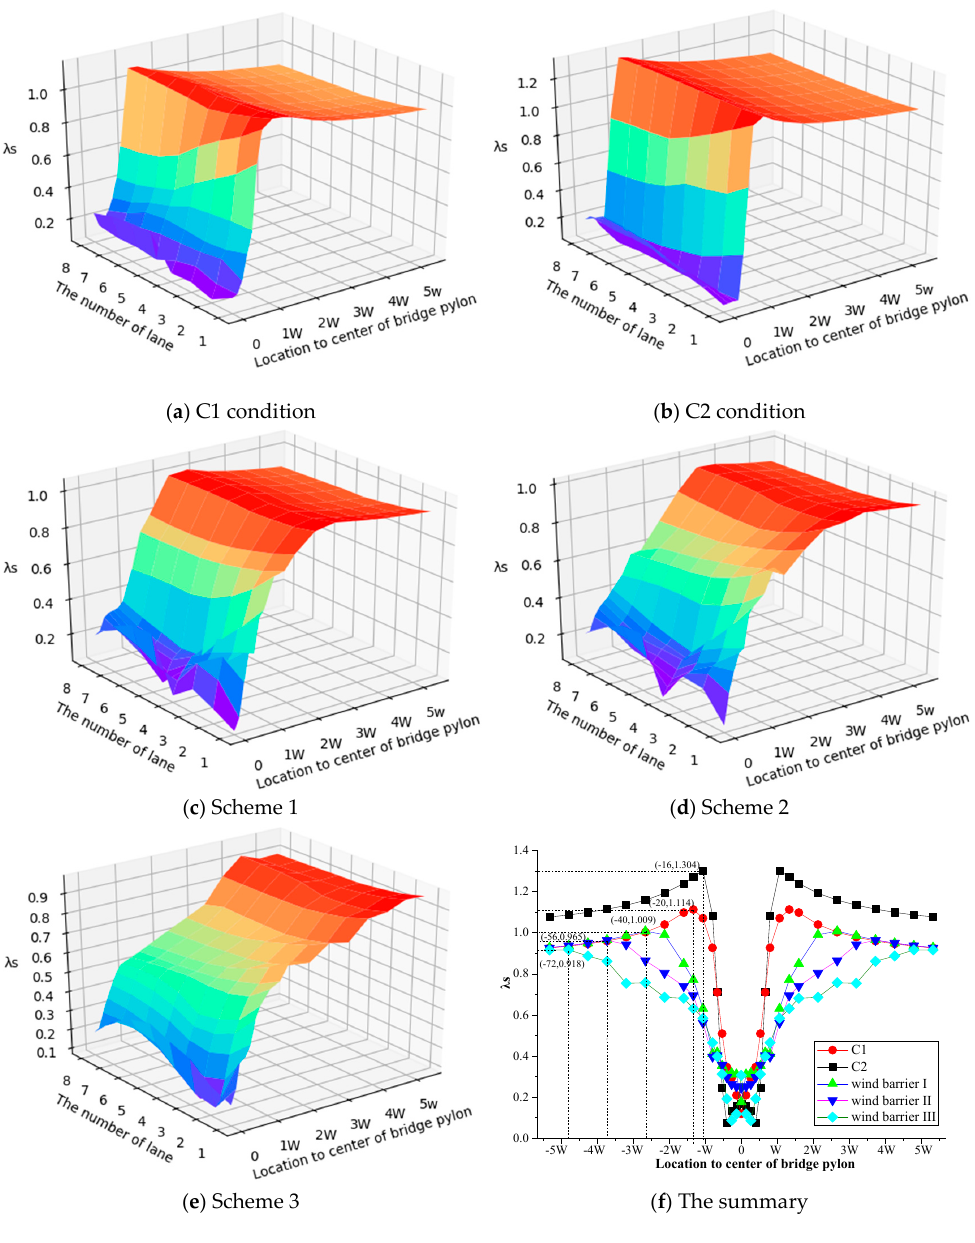
Figure 19. The influence coefficient λ s. Table 2. The concrete size of wind